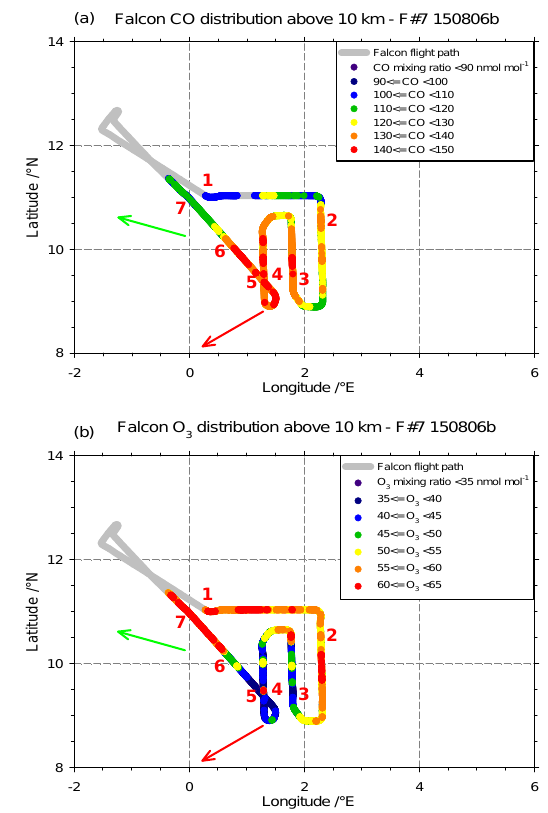
Fig. 16. Distribution of CO (a) and O 3 (b) mixing ratios along the Falcon flight path above 10 km on 15 August 2006. The selected flight segments are labelled. The red arrow indicates the direction of the storm motion and the green arrow the main wind direction in the anvil outflow (not scaled according to velocity).